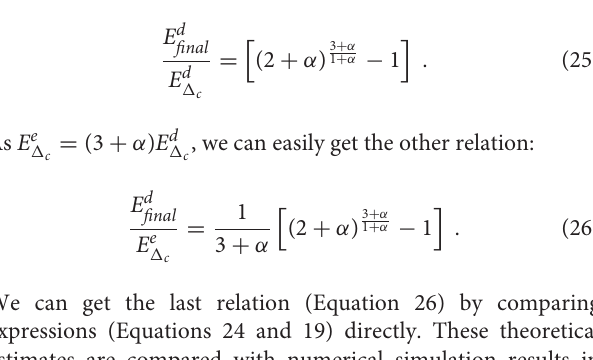
FIGURE 4 | Ratio between damage energy of final catastrophic avalanche and elastic energy at the failure point 1 c vs. power law exponent α . Single bundle with N 10 7 fibers. The dashed line is the theoretical estimate (Equation =